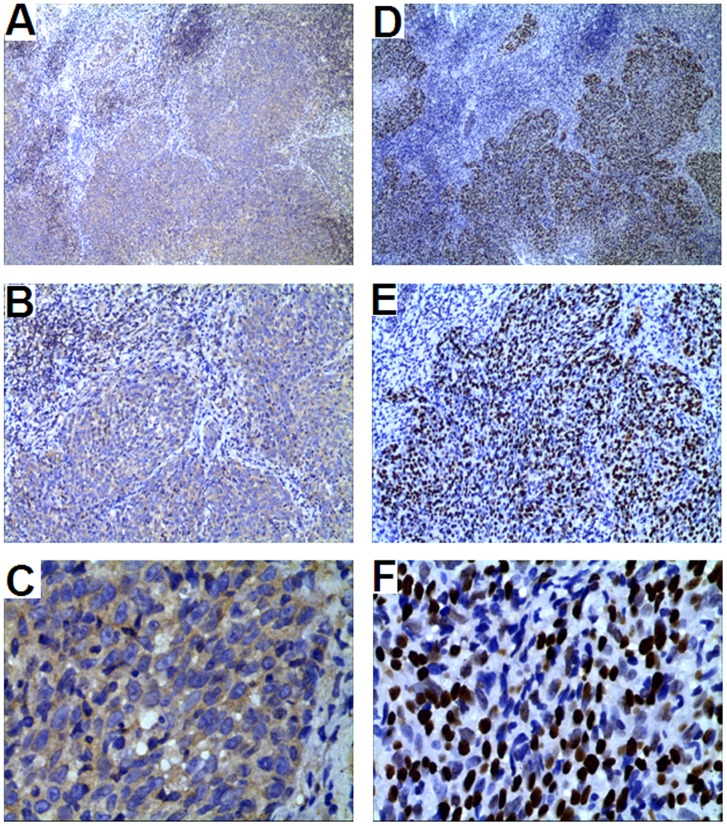
Immunohistochemical analysis of p53 and pAkt expression in NPC tissues.Brown cytoplasmic staining of tumor cells, indicative of positive pAkt, shown in A (x40), B (x100), and C (x400); Brown nuclear staining of tumor cells, indicative of positive p53, shown in D (x40), E (x100), and F (x400).